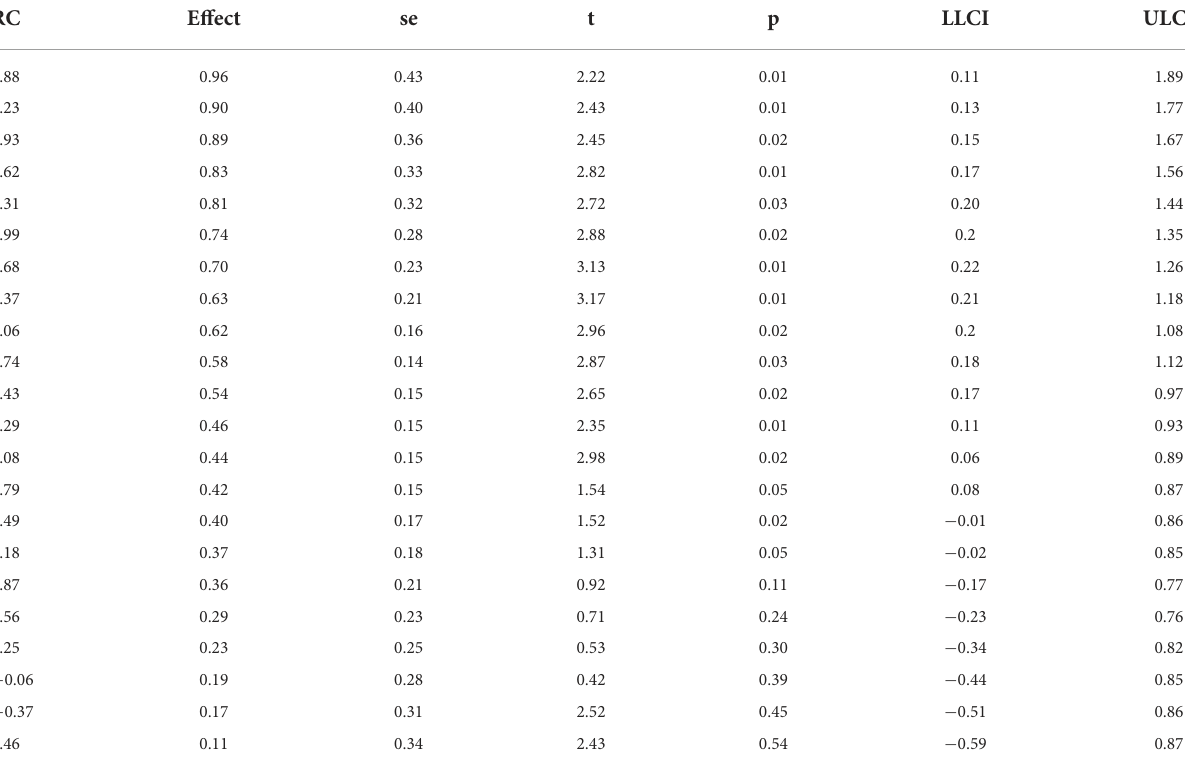
TABLE 5 Conditional effect for different values of the moderator (RC) using the Johnson-Neyman technique. RC